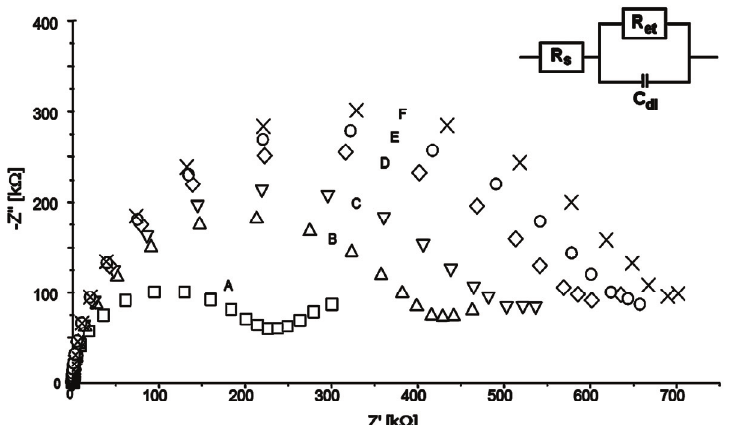
Figure 5 . Impedance spectra of immunosensor: in pure PBS (A); in the presence of antigen protein rSPI2-His6 in concentrations 10 pg/mL (0.13 pM) (B); 30 pg/mL (0.39 pM) (C); 0.1 ng/mL (1.31 pM) (D); 0.3 ng/mL (3.93 pM) (E) 1.0 ng/mL (13.10 pM)